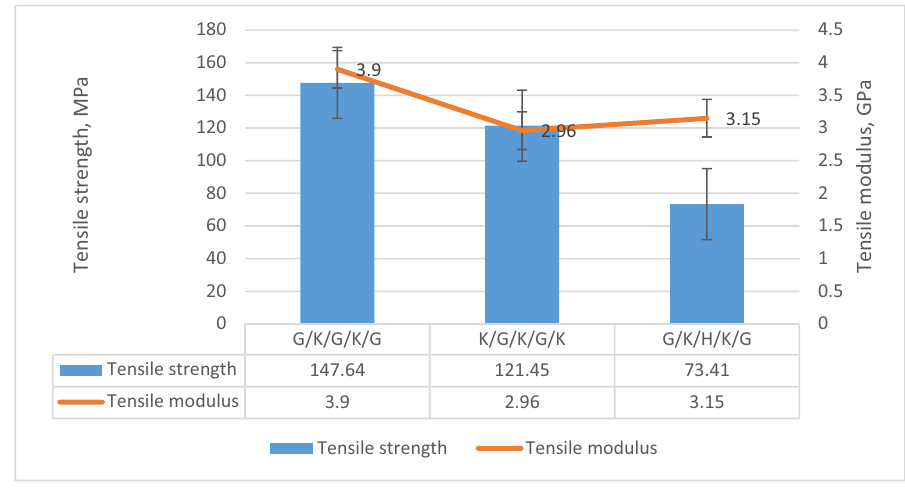
Figure 4: Tensile strength and modulus of the laminate